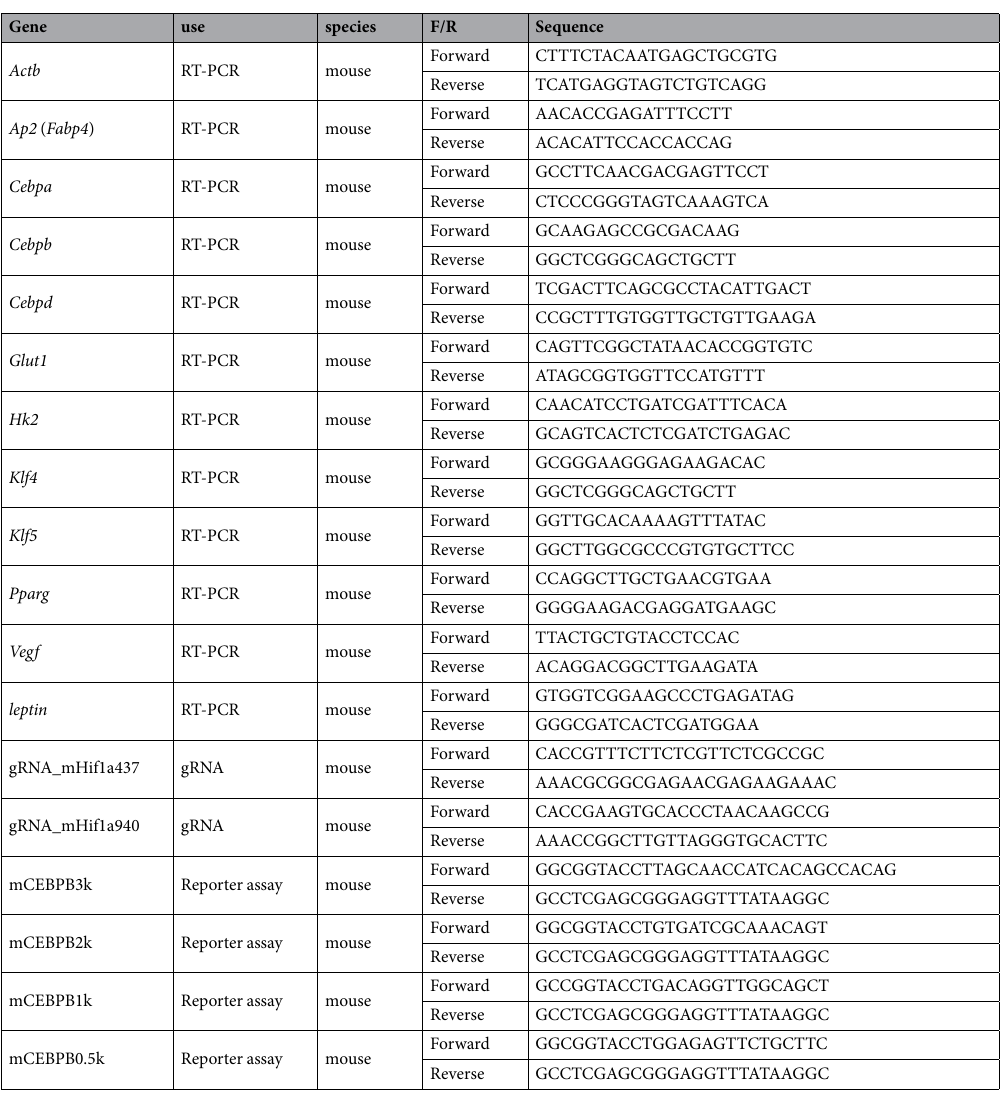
Table 1. A list of primers used in this